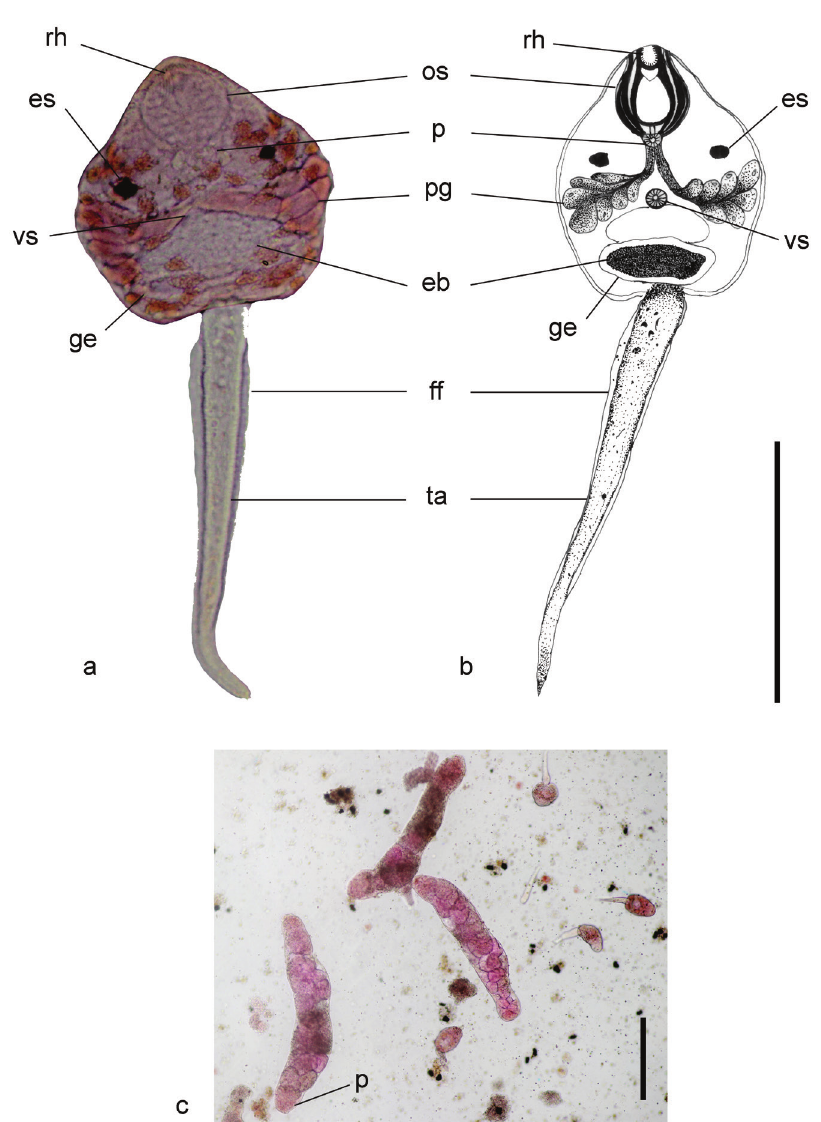
Figure 11. Centrocestus formosanus (Nishigori, 1924). a . Specimen stained with 0.5% neutral red. b . Drawing of cercaria. c . Redia stained with 0.5% neutral red. Abbreviations – eb: excretory bladder; es: eyespot; ff: finfold; ge: genital primordium; os: oral sucker; p: pharynx; pg: penetration gland; rh: rostellar hooks; ta: tail; vs: ventral sucker. Scale bars: 50